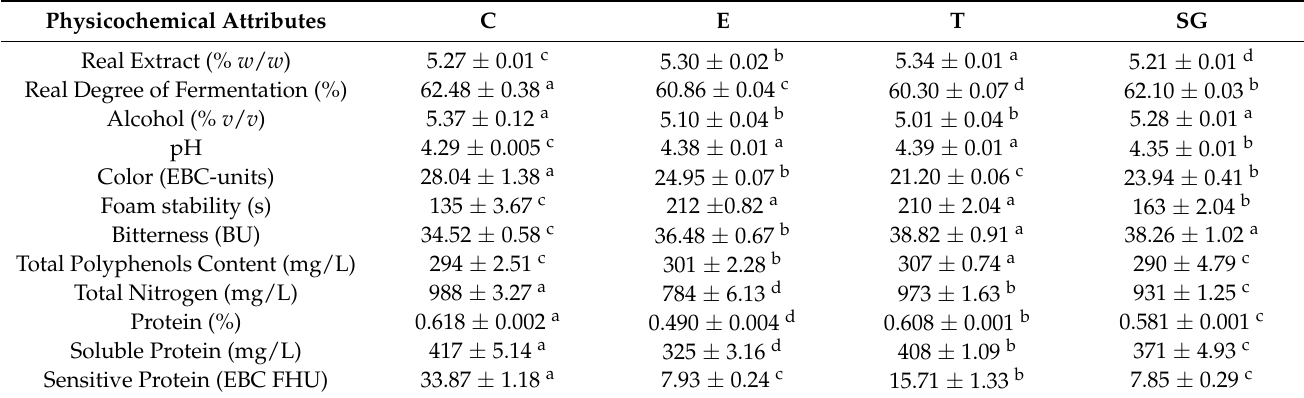
Table 1. Physicochemical attributes of the experimental beer